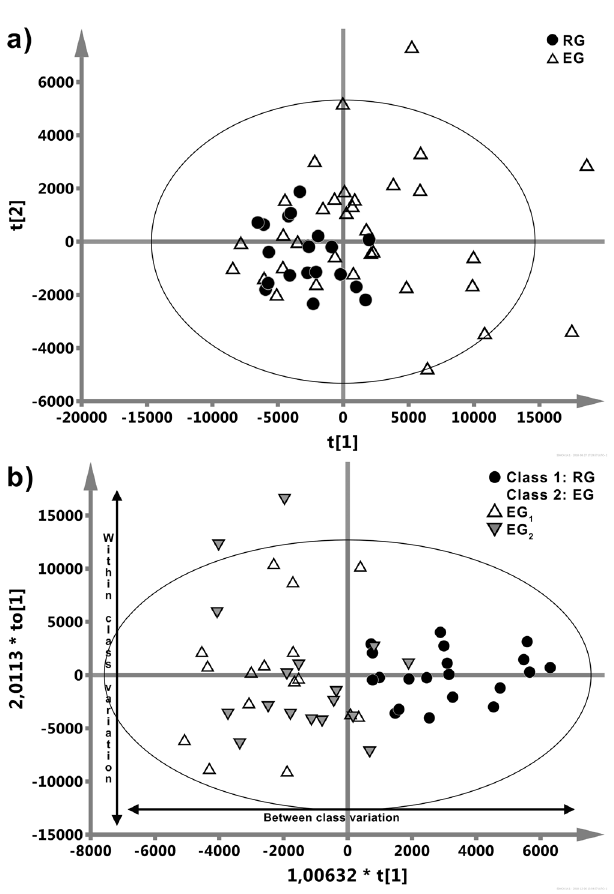
Figure 2. ( a ) PCA analysis of 1 H CPMG NMR serum spectra shows clustering of the epileptic (EG, Δ ) and non-epileptic (RG, • ) children. ( b ) The R2X scaled (distances in the plot correspond with the explained variation) score plot obtained from the OPLS-DA analysis of 1 H CPMG NMR spectra of serum samples from the patients with epilepsy (EG 1 , Δ , EG 2 , ▼ ) and the reference subjects without epilepsy (RG, • ). The information about seizures in EG patients (EG 1 and EG 2 ) was not implemented into the OPLS-DA model and is used purely for a visual assessment of data